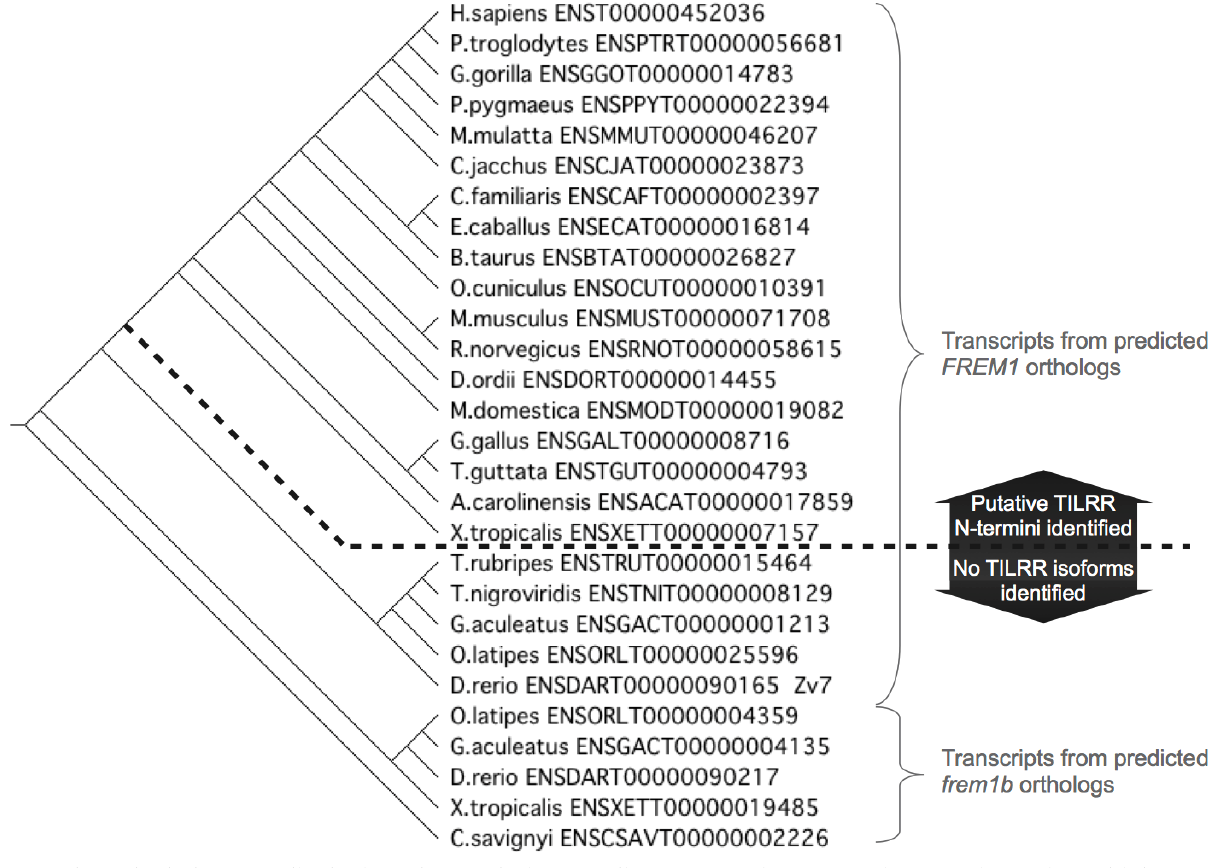
Figure 6. Evolutionary development of FREM1 and presence of putative TILRR sequence.